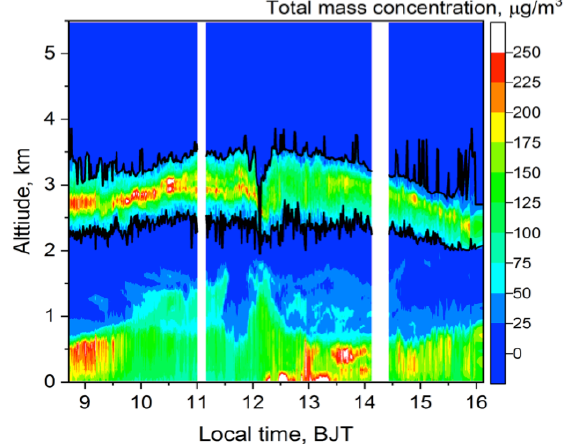
Figure 5. Particle mass concentration profiles derived from mobile lidar and sun photometer measurements on 17 May 2017 along the transect from Tianjin to Tangshan The mean mass concentration in the dust layer was 95 ± 52 µ g m -3 with a maximum of 284 µ g m - 3 . The mean mass concentration in the PBL